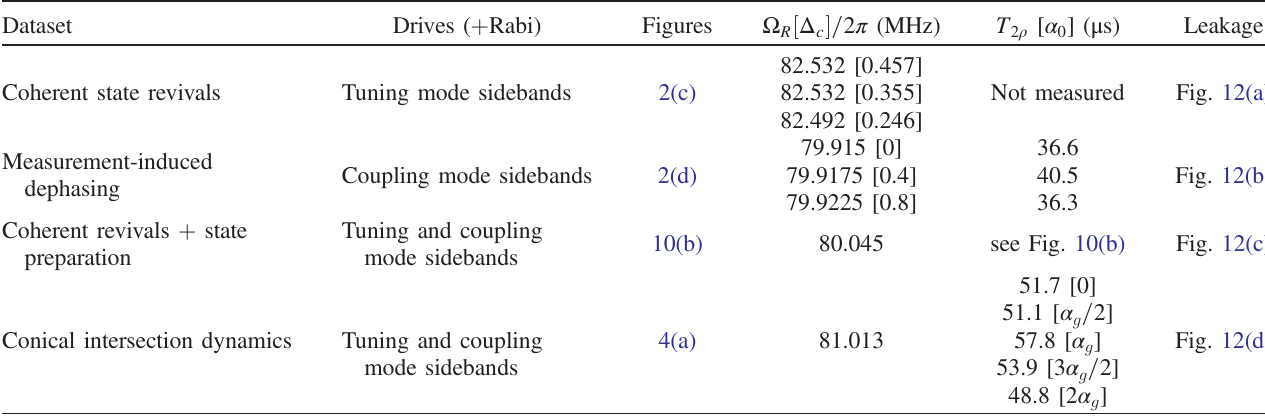
TABLE II. Extended data information. Quantities in brackets correspond to identifiers within a dataset. Different values of Δ c ∈ f a; b g , require a fine-tuning calibration on the drive configuration to match Rabi frequency shifts, but preparing different initial states does